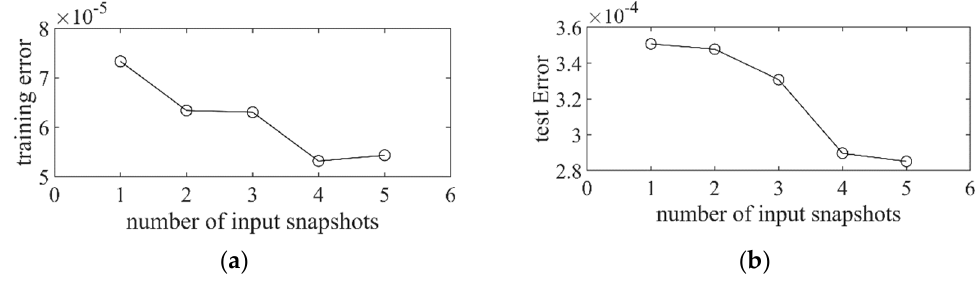
Figure 10. Mean square error as a function of the number of input snapshots; ( a ) and ( b ) present the computational errors of the CNN for the training and test dataset, respectively.